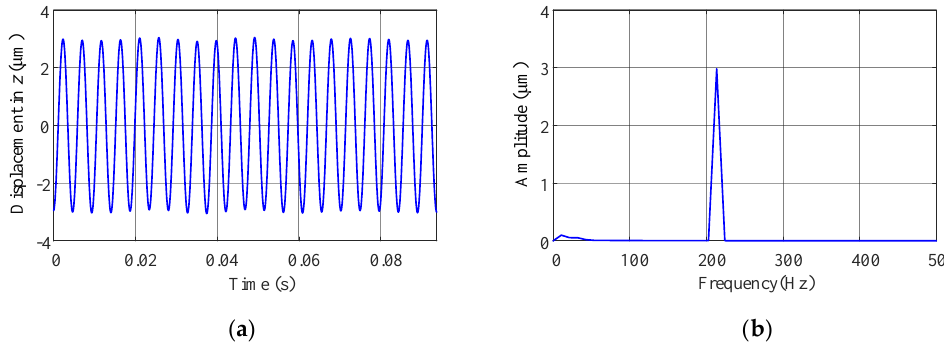
Figure 7. Orbits of high-pressure rotor at low speed.